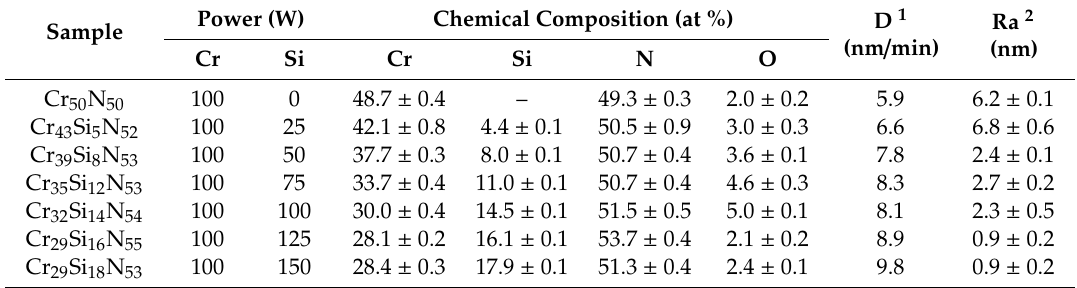
1 D: Deposition rate. 2 Ra: Surface roughness.